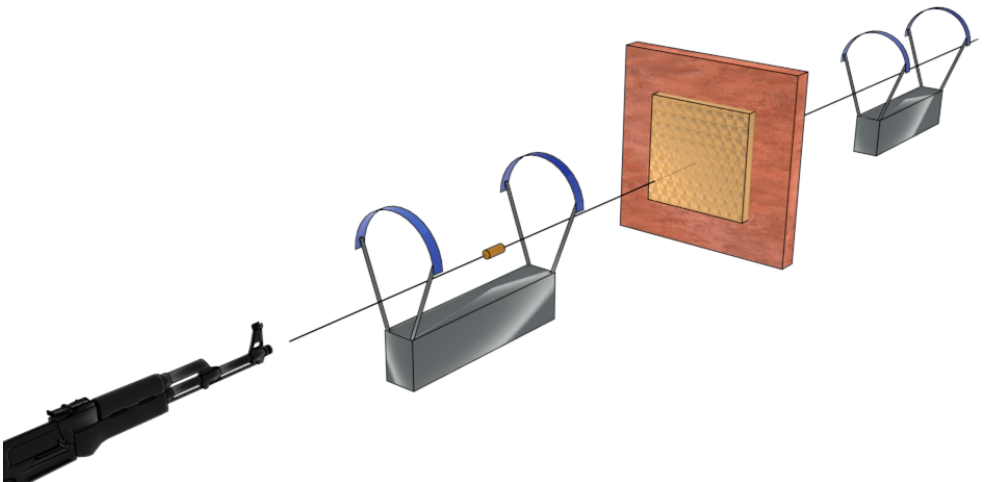
Figure 5. Schematic figure of ballistic test